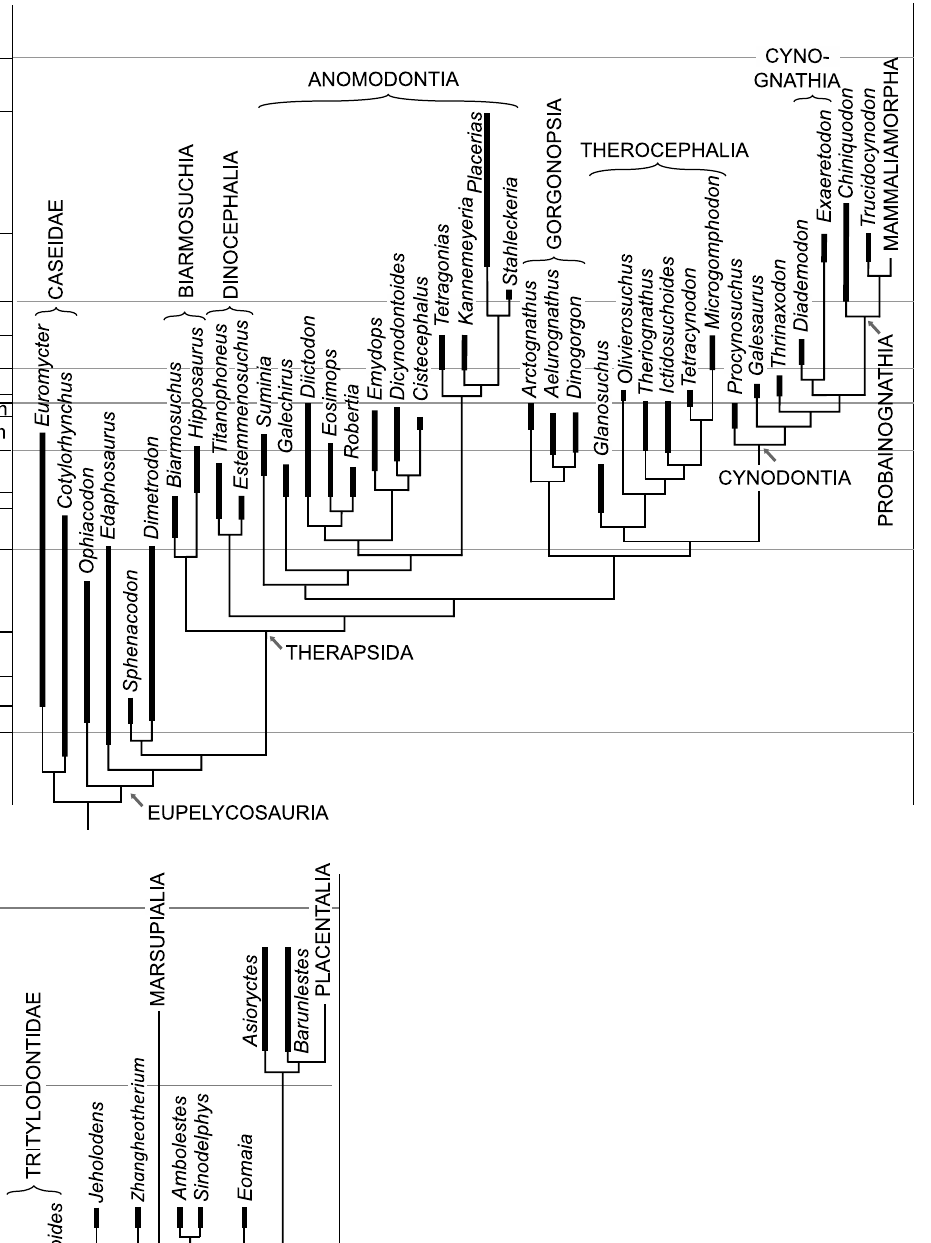
Fig. 2. Cladograms of fossil Synapsida. The cladograms are compromise trees in which different phylogenetic hypotheses were considered. Because of small space, some age names are not included in the cladogramms. These are: Wordian in the Guadalupian; Induan in the Lower Triassic; Hettangian in the Early Jurassic; Bajocian, Bathonian and Callovian in the Middle Jurassic and Santonian in the Late Cretaceous. Geological timescale after Cohen et al. (2013, updated), correlations after Schneider et al. (2020). A . Non-therapsid Synapsida (after Reisz 1986; Modesto et al. 2011; Reisz et al. 2011), Dinocephalia (after Kammerer 2011), Anomodontia (after Maisch 2001; Vega-Dias et al. 2004; Fröbisch and Reisz 2011; Kammerer et al. 2011; Angielczyk and Rubidge 2013), Gorgonopsia (after Kammerer 2016; Kammerer and Masyutin 2018; SK personal communication with Christian Kammerer 2019), Therocephalia (after Huttenlocker and Smith 2017), non-mammaliamorph Cynodontia (after Abdala 2007; Ruta et al. 2013). B . Mammaliamorpha (after Kielan-Jaworowska et al. 2004; Watabe et al. 2007; Luo et al. 2011; Ruta et al. 2013; Bi et al. 2014, 2018; Velazco et al.